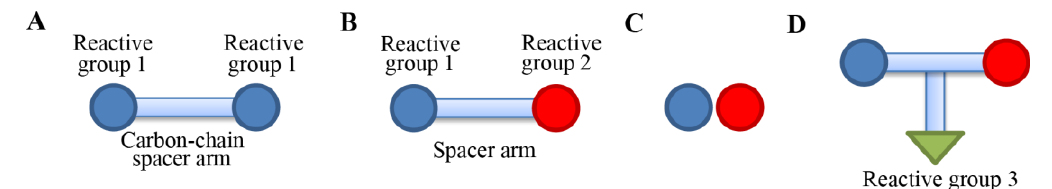
Figure 2. Four types of cross-links (adapted from figure 3 of [26]). ( A ) Homo-bifunctional; ( B ) Hetero-bifunctional; ( C ) zero-length; and ( D ) hetero-trifunctional